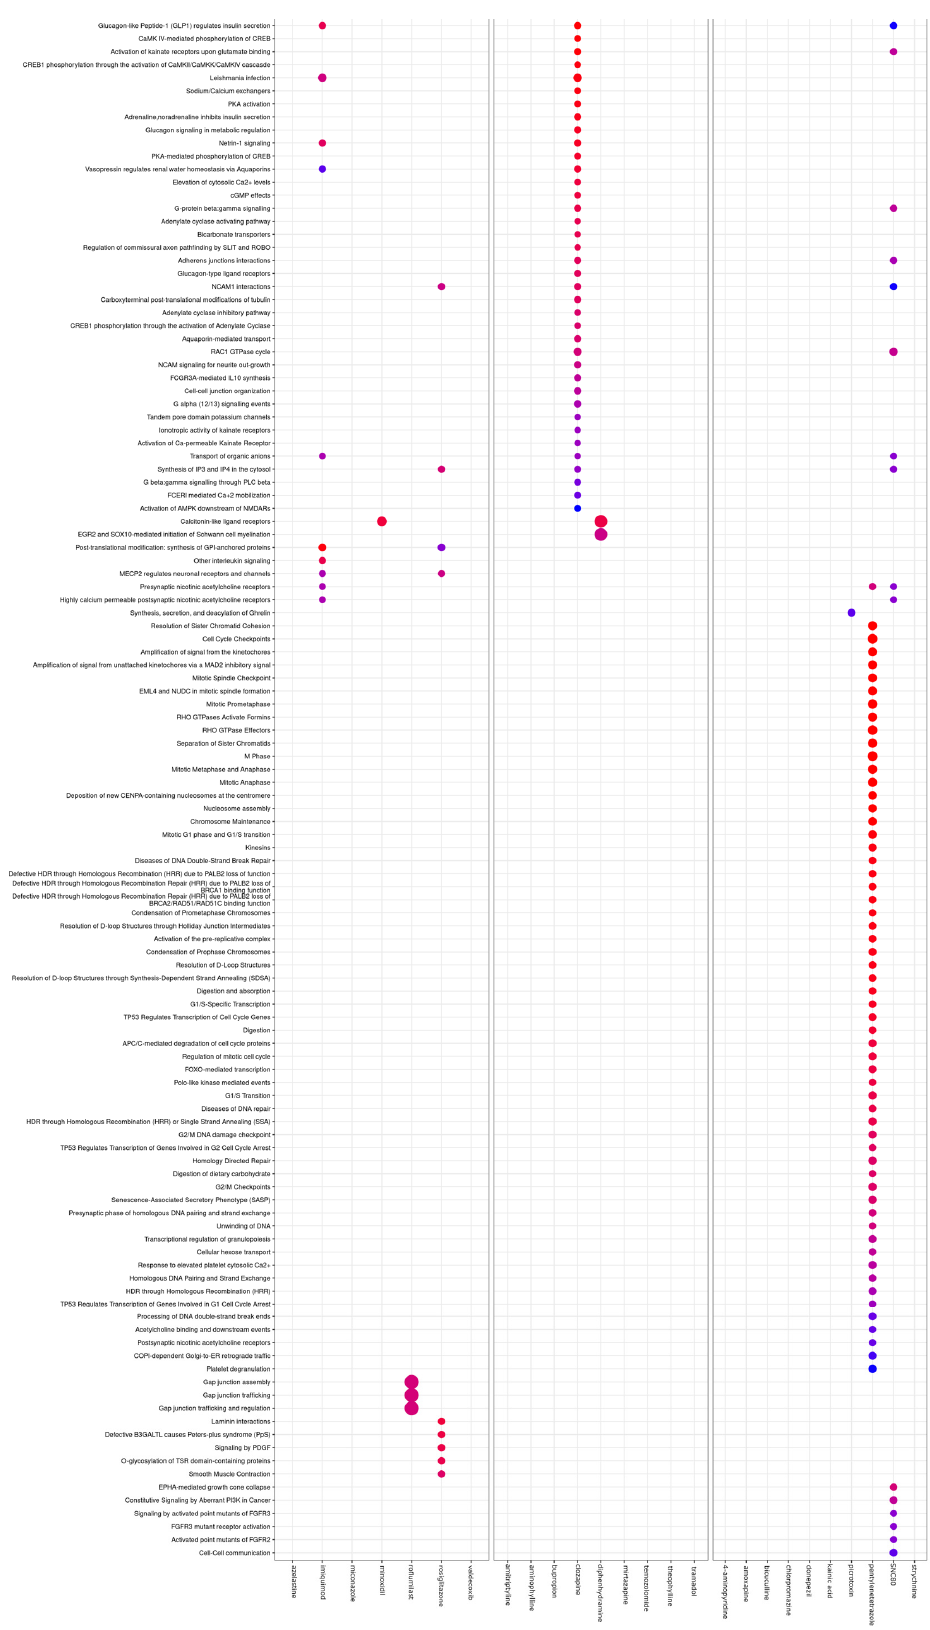
Figure 3. Enriched Reactome pathways (y-axis) induced by tool, FAERS-positive, and FAERS negative compounds (x-axis). Pathways were identified, compared, and visualized by